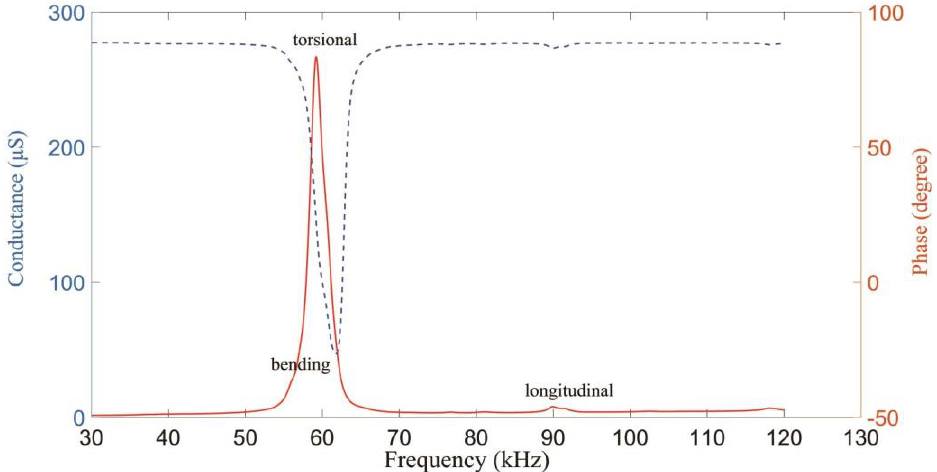
Figure 6. Dynamic abilities of the piezoelectric tube actuator.